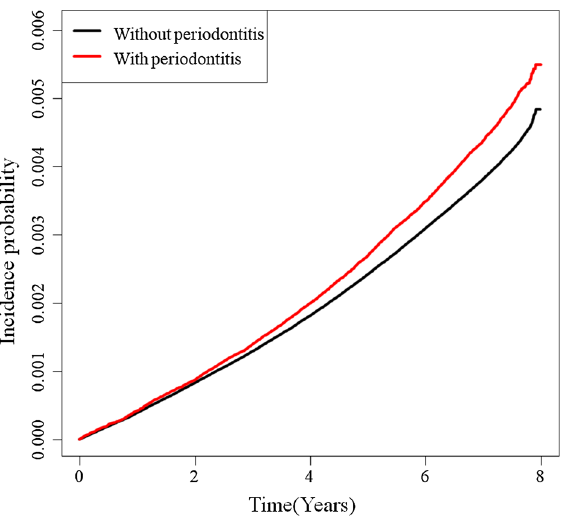
Figure 1. Kaplan–Meier curves of the incidence probability for Parkinson’s disease categorized by the presence of periodontitis. The incidence probability of Parkinson’s disease was higher with the presence of periodontitis (log rank P < 0.001).